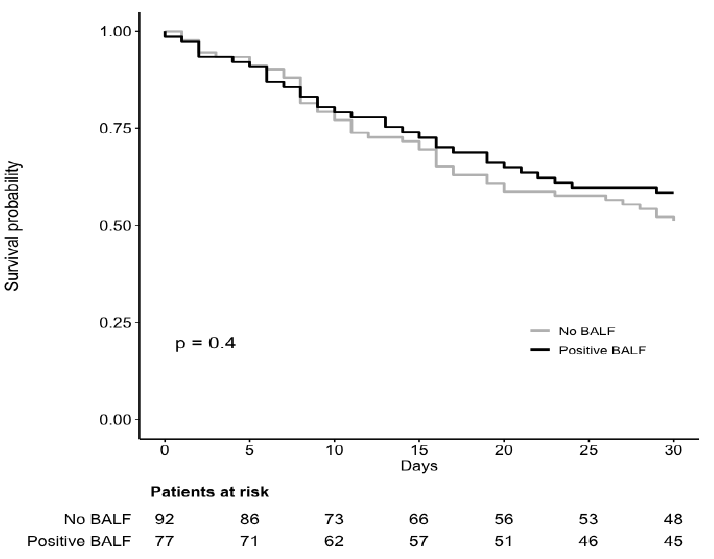
Figure 1. Survival in critically ill COVID-19 patients with VAP. Comparison of survival in patients who did not underwent bronchoscopy and patients with positive culture of bronchoalveolar lavage fluid (BALF) at ventilator-associated pneumonia (VAP) onset. The time of origin was set at the day of VAP onset. p -value is from log-rank test. Two patients with negative BALF cultures were excluded from this analysis.